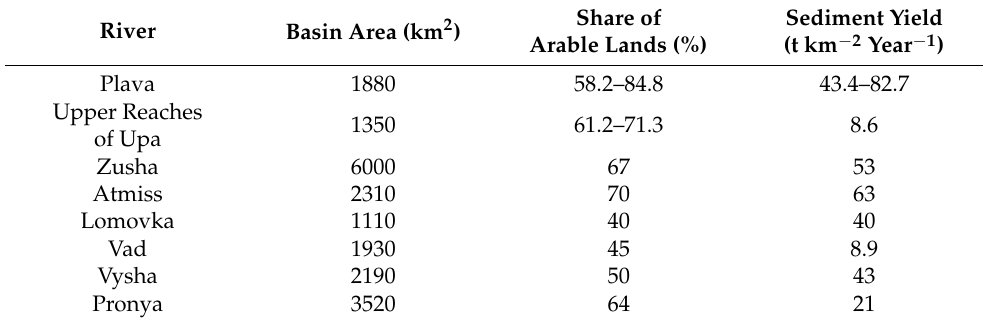
Table 6. Calculated sediment yield for Plava and upper reaches of Upa River basins in comparison with corresponding values of other rivers of forest steppe and south of forest zones in Oka River basin, which we obtained based on long-term observations of water and suspended sediment discharge (based on Golosov, 1989 [146]).